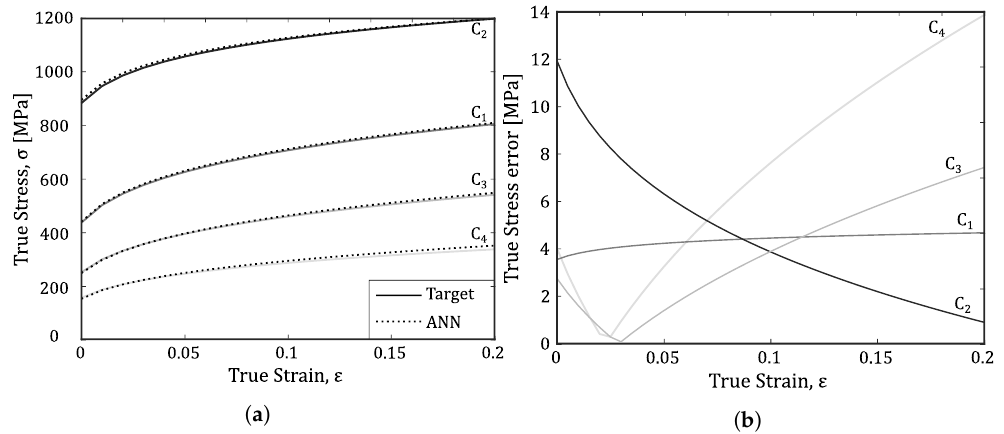
Figure 18. True stress–strain curves ( a ) for cases C 1 to C 4 considering the Swift parameters obtained using ANN and its comparison with the expected target results; ( b ) corresponding true stress error ( | σ Target − σ ANN | ) for each case and true strain values between [0, 0.2]. Table 6. Relative error [%] between the target reference and the ANN output values of four different cases ( C 1 to C 4 ) and considering two Swift parameters ( K and n ). K